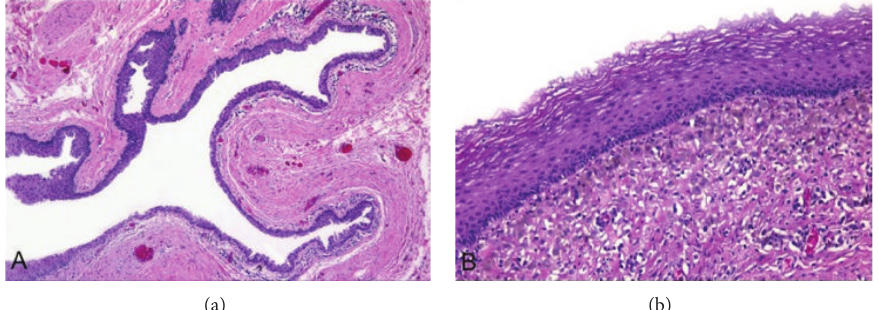
Figure 1: (a) Invaginated intradermal cyst. (b) Paved areas with stratified squamous epithelium (hematoxylin and eosin, magnifications (a) × 50, (b) × 200).